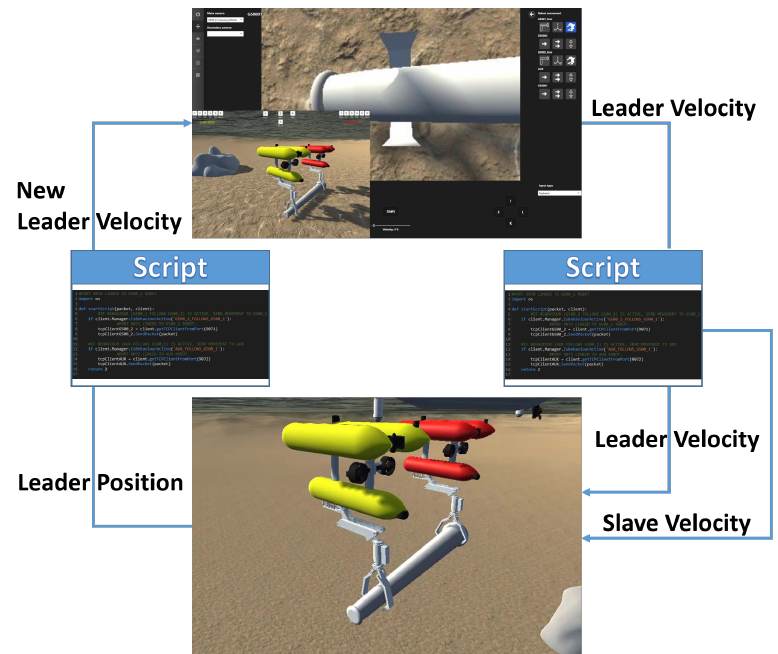
Figure 10. Example of cooperative transport of the pipe for recovery with the leader (yellow) and the slave (red) robots in cooperative